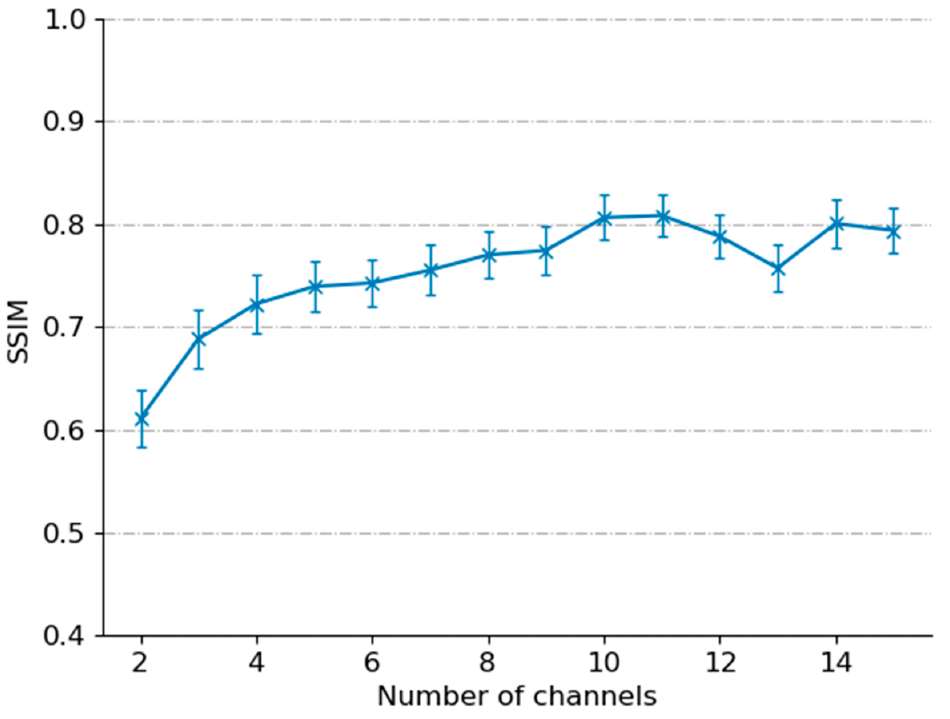
Figure 4. The plot of SSIM with a different number of channels. 11 channels provided the highest SSIM.